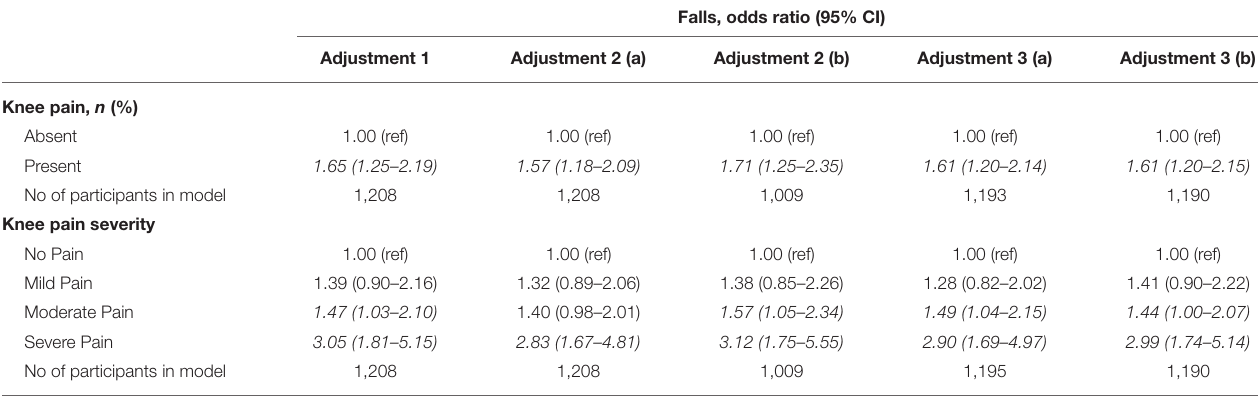
TABLE 3 | Multivariate analysis on the influence of knee pain and knee pain severity on